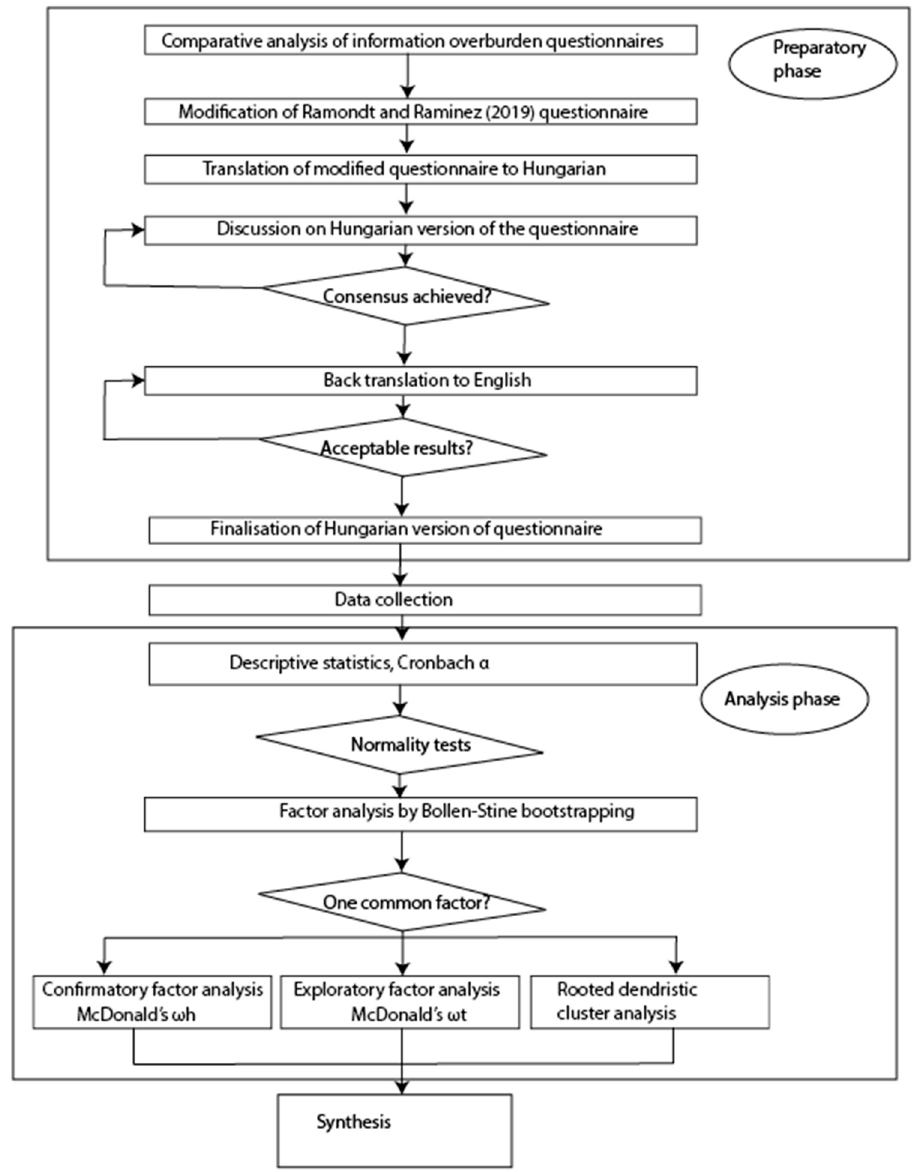
Figure 2. Workflow of data analysis. The rectangles show different steps, built on each other, and points, in some cases, the hooks and the rhomboids—in line with the general practice of block-diagram building—symbolize the deci- sion points, in some cases, the hooks and cycles.